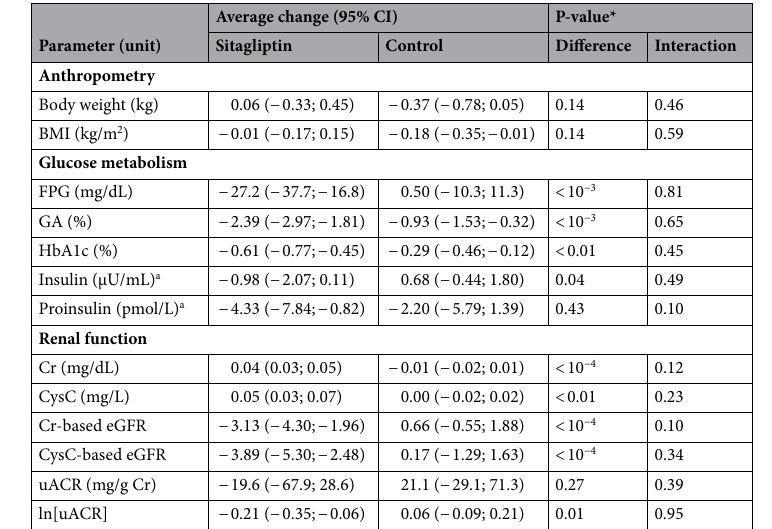
Table 3. Average changes in parameters of primary and secondary outcomes during treatment based on a mixed-effects model analysis. *‘Difference’ indicates the average change in parameters of primary and secondary outcomes caused by a specific treatment. ‘Interaction’ occurs when the length of treatment affected the average change in a selected parameter. a Follow-up measurements were performed at 3 and 6 months. BMI